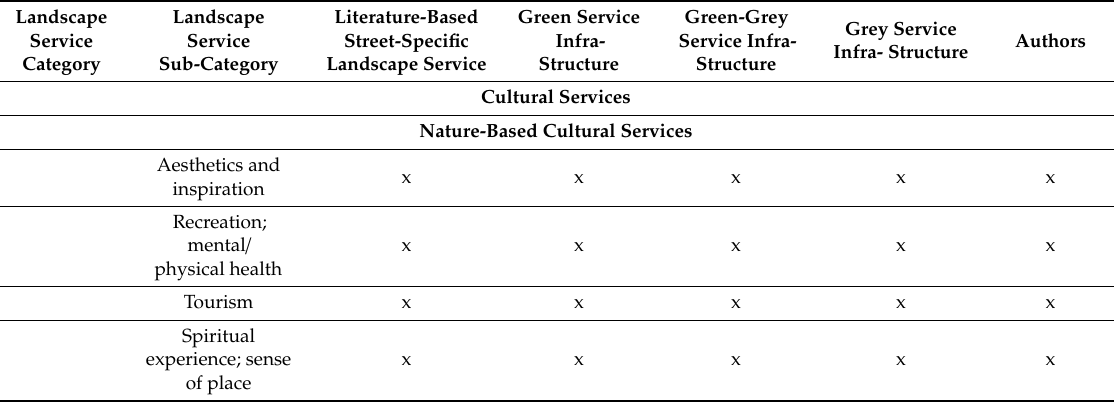
Table A3. Street retrofit infrastructure landscape